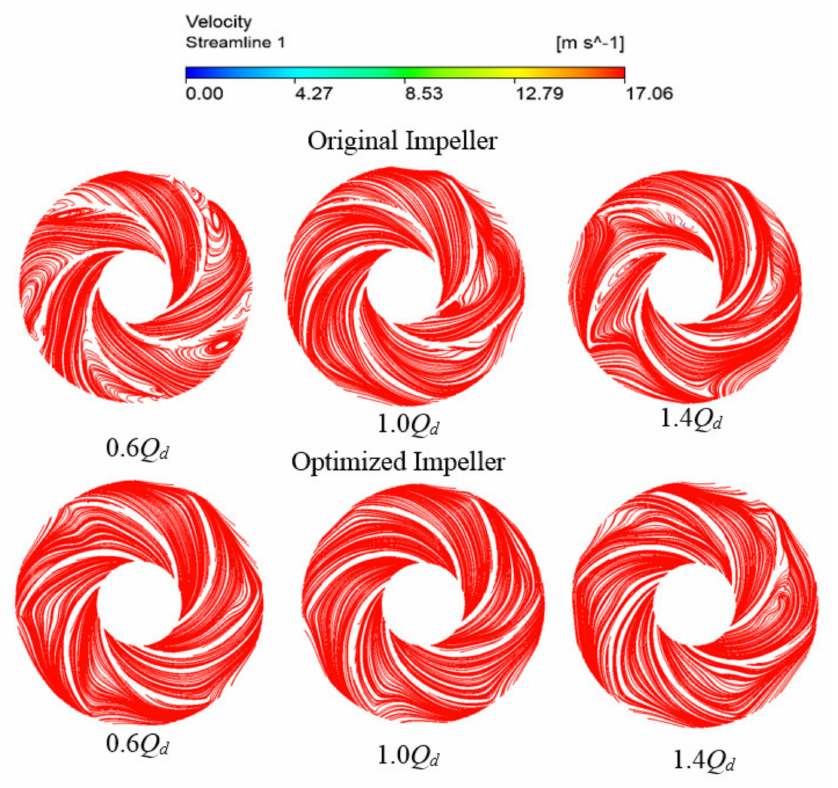
Figure 22. Compared streamlines on blade